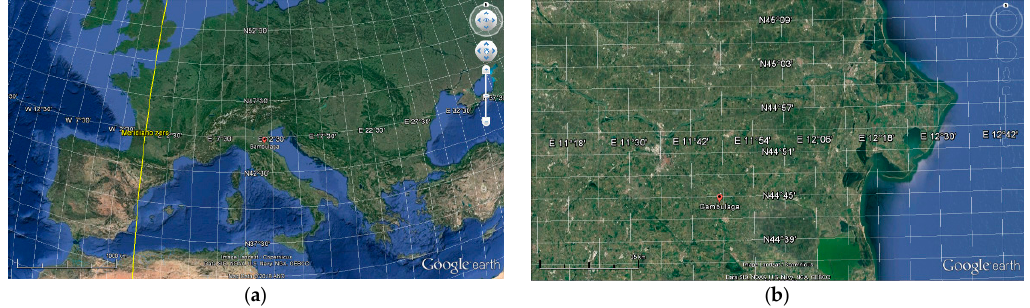
Figure 1. Satellite images of Gambulaga, Portomaggiore (Ferrara District (FE), Italy): ( a ) Position of the site; ( b ) River Po Delta (Google Earth Satellite Images, accessed on 22 Janurary 2018).